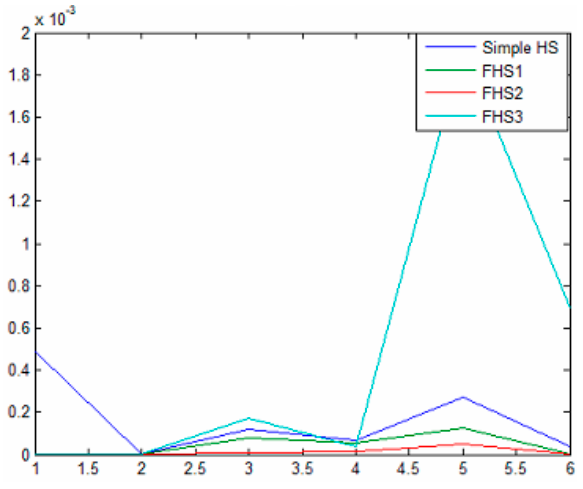
Figure 15. Plot of three proposed fuzzy HS.